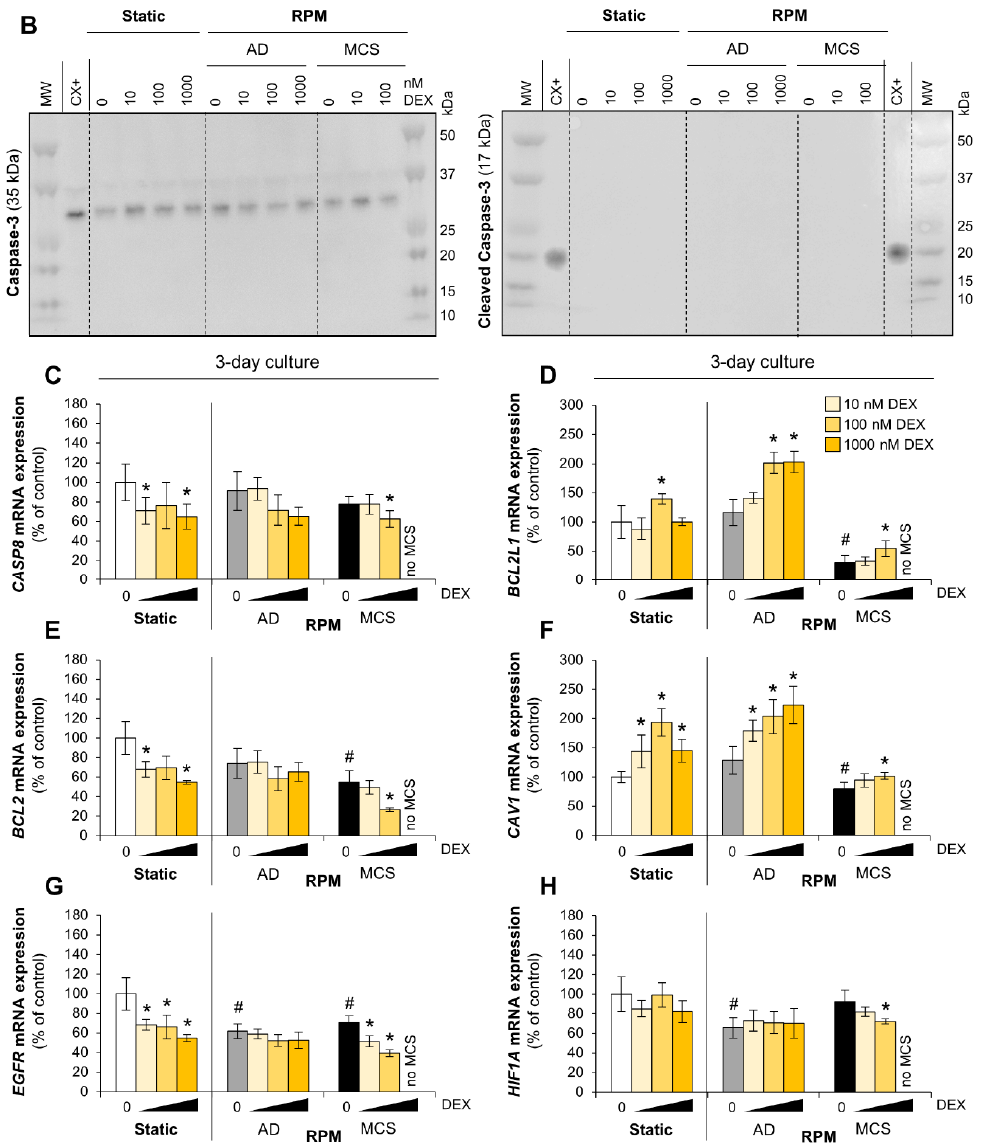
Figure 7. Effect of DEX on apoptosis and anoikis-related proteins in FTC-133 cells. ( A ) No apoptotic cells (green nuclei) were detected by transferase dUTP nick-end labeling (TUNEL) staining after